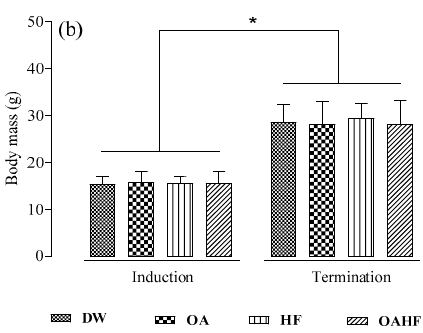
Figure 1. The effect of neonatal oral administration of oleanolic acid on the growth rates ( a ) and the induction (postnatal day 7) and terminal (postnatal day 14) ( b ) of suckling male and female pups. Data presented as mean ± standard deviation. * Significant increase in body mass from induction to termination for all treatment groups ( p < 0.05). DW = gavaged daily with 10 mL/kg body mass of distilled water with 0.5% ( v/v ) dimethyl sulphoxide in the neonatal phase ( n = 8); OA = gavaged daily with 10 mL/kg body mass of oleanolic acid (60 mg/kg) in the neonatal phase ( n = 8); HF = gavaged daily with 10 mL/kg of 20% ( w/v ) fructose solution in the neonatal phase ( n = 7); OAHF = gavaged daily with 10 mL/kg body mass of oleanolic acid (60 mg/kg) and 20% ( w/v ) fructose solution in the neonatal period ( n = 7). Table 1. The effect of neonatal oral administration of oleanolic acid on tibial and femoral masses, lengths and Seedor indices in suckling male and female pups.